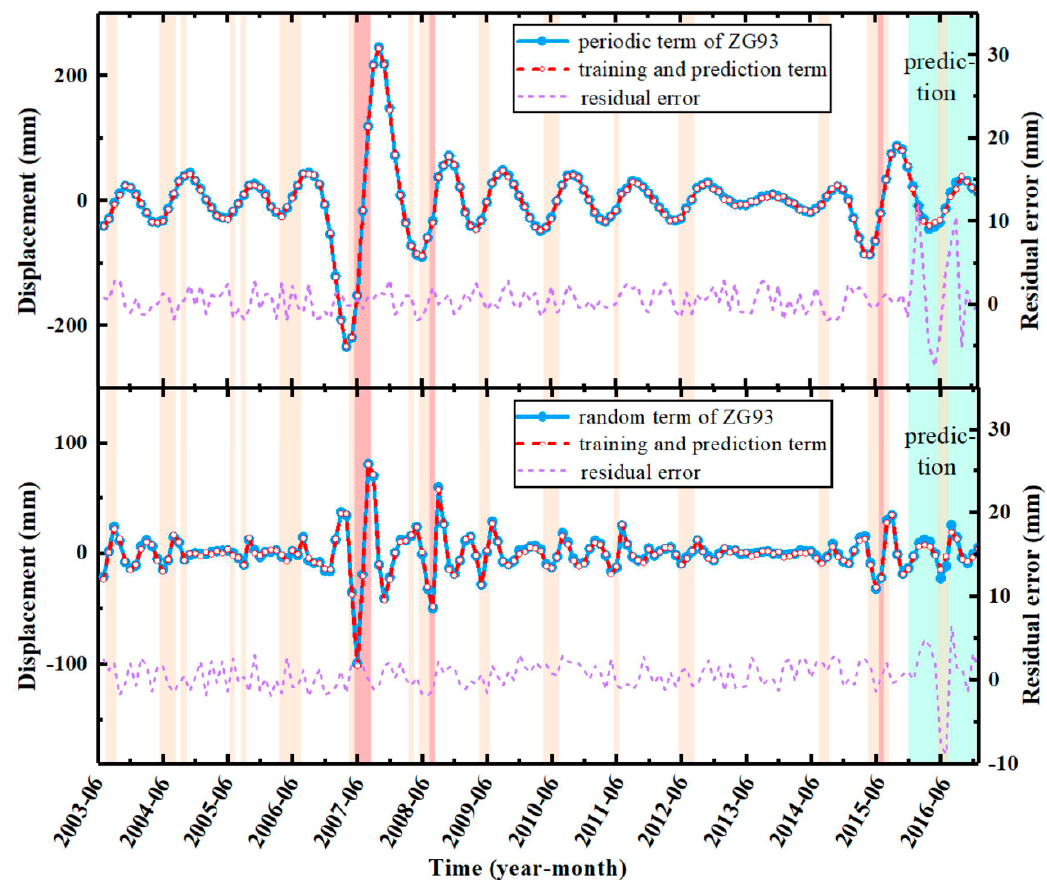
Figure 15. Training and prediction curves of the periodic and random terms.